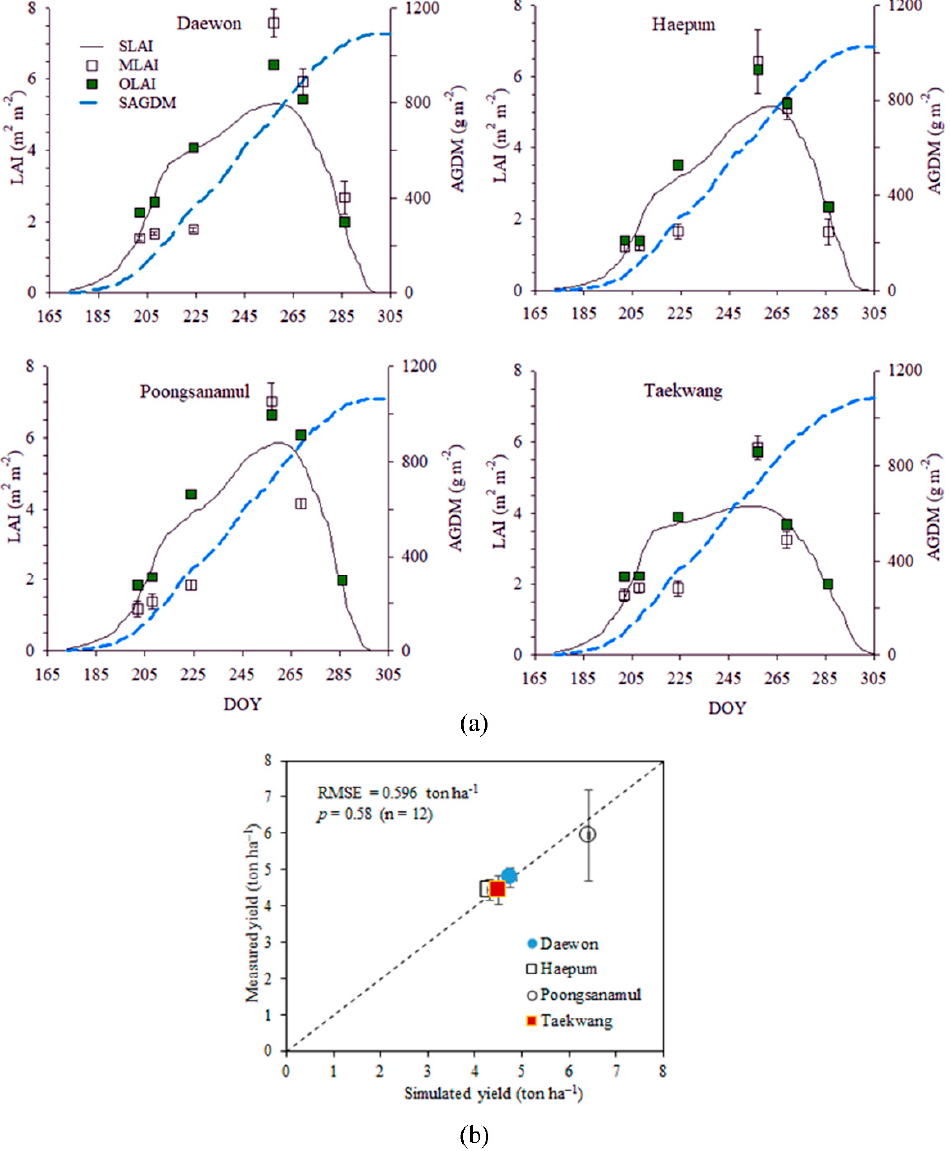
Figure 9. Model validation: Simulated (S) and observed (O), measured (M) values in leaf area index (LAI) and S values in above ground dry mass (AGDM) for four soybean cultivars, Daewon, Haepum, Poongsanamul, and Taekwang ( a ), and comparisons between S and M values in soybean yield ( b ) for model validation. The data set was obtained at Jeonnam Agricultural Research and Extension Services in Naju, Chonnam province, South Korea in 2017. Vertical and horizontal error bars represent the standard deviations of the means values. RMSE and p denote root mean square error and the p value according to the two-sample t -test.